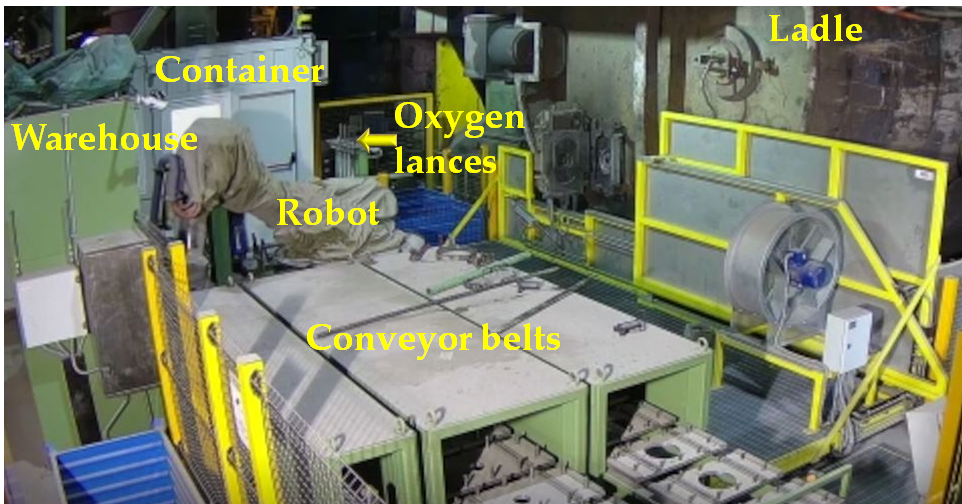
Figure 2. Overview of the robotic cell.